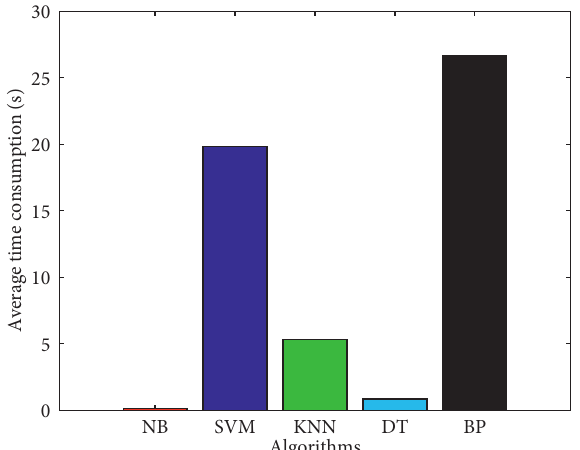
Figure 3: Average running time of different Table 2: Classification accuracy of NB algorithm and WNB algorithm.